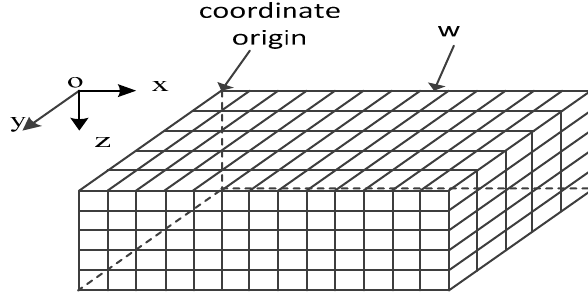
Figure 1. Coordinate system for UWSNs.